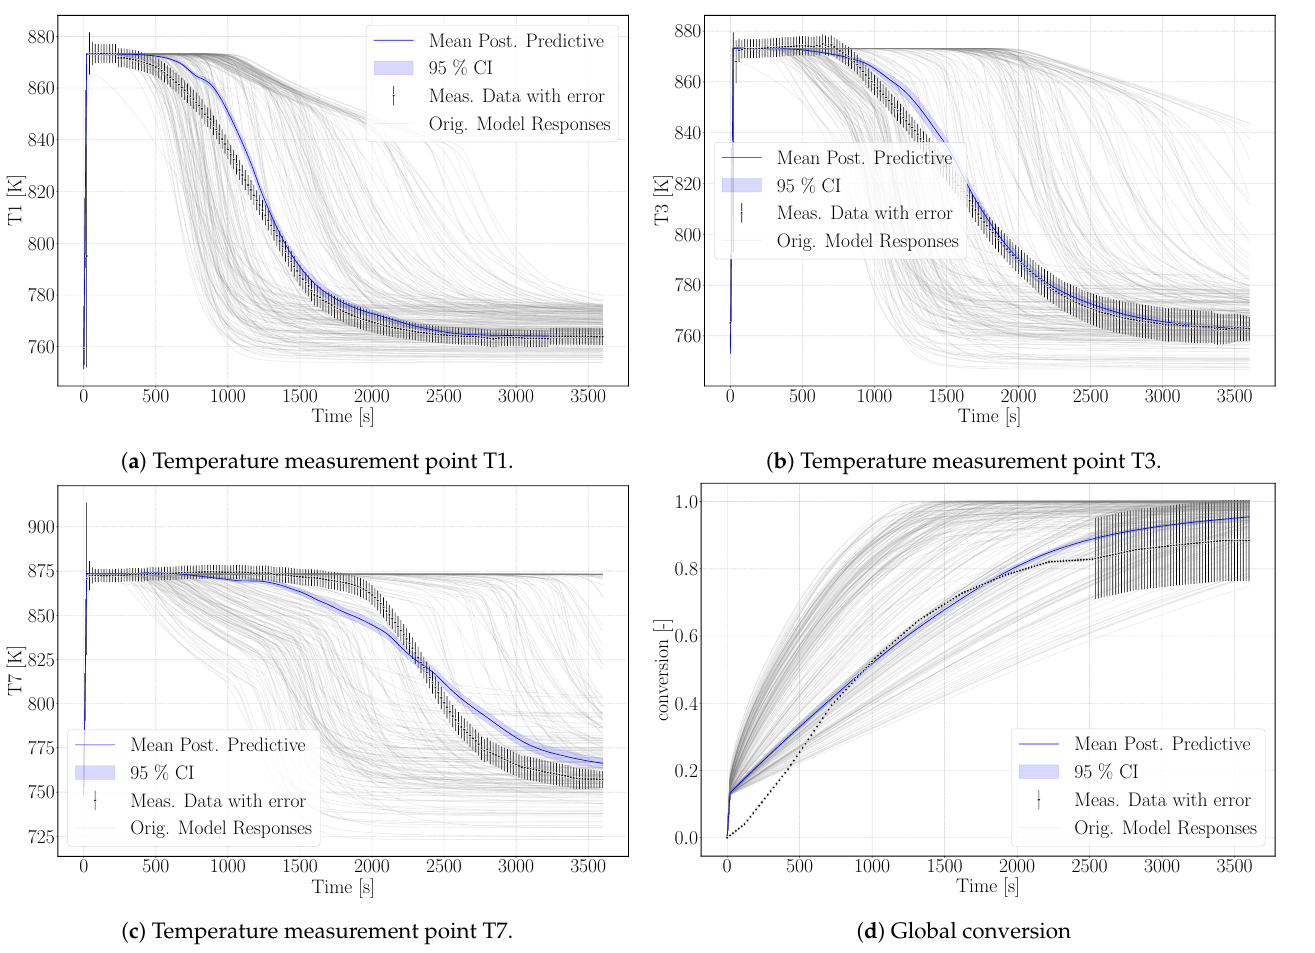
Figure 5. Simulation results of the calibrated surrogate model with its 95% confidence interval (CI); the surrogate model is based on 200 simulation runs of the numerical model plotted in gray. The experimental reference data are plotted in black including error-bars representing the